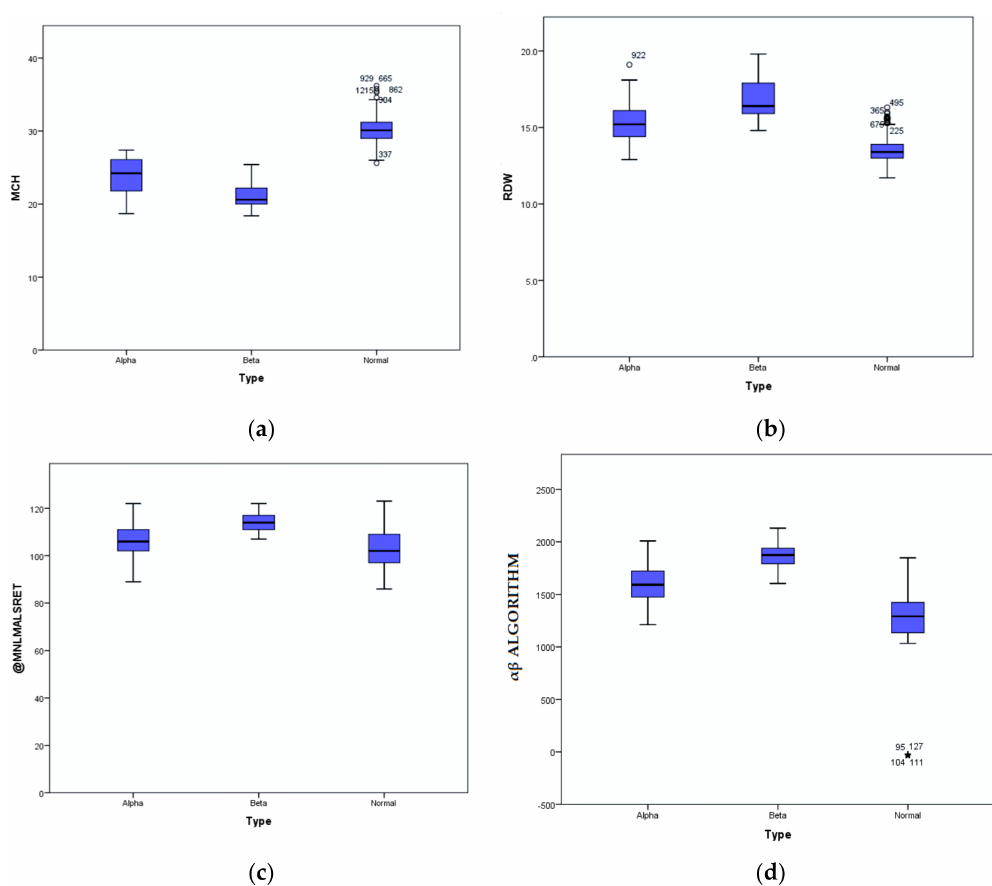
Figure 3. ( a – d ) Box and whisker plot for MCH, RDW, MN-LMALS-RET (labelled as @MNLMALSRET in Figure 3c and the αβ -algorithm between the α and β -thalassaemia trait and the control group (apparently healthy subjects). * refers to the